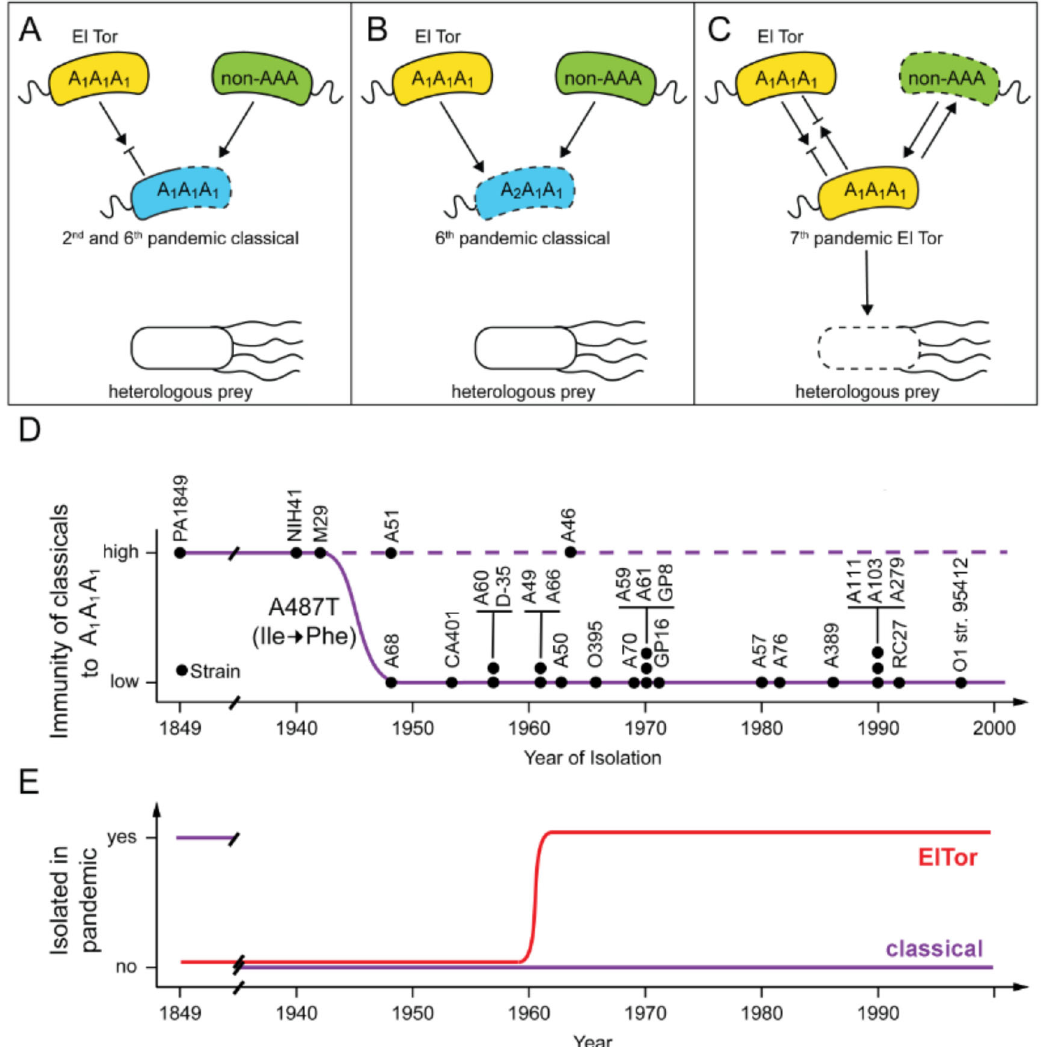
Fig. 5 Model for the competitive behaviour of non-classical and classical V. cholerae O1 serogroup strains. Panels ( A – C ) depict intraspeci fi c T6SS- mediated interactions among V. cholerae strains (yellow, azure and green bacteria) and interspeci fi c competition with heterologous pray (white bacterium) not susceptible to killing by any classical pandemic V. cholerae due to a disabled vasN Δ 293-304 allele. Classical V. cholerae are illustrated as azure bacteria, El Tor biotype are shown in yellow and non-AAA V. cholerae are fi lled in green. Dashed cell outlines represent vulnerability to attack. For clarity, interactions shown here focus exclusively on the compatibility vs vulnerability of pandemic strains (centre). A 2nd and early 6th pandemic classical V. cholerae bacteria (azure, centre) are sensitive to T6SS-mediated attack (dashed cell outline) by non-AAA V. cholerae strains (green, top right). However, compatible immunity proteins protect them against strains belonging to the same compatibility group (continuous cell outline) such as El Tors (yellow, top left). Heterologous prey bacteria are unaffected by 2nd and early 6th pandemic classical V. cholerae. B Ile163Phe conversion of TsiV1 from subfamily A 1 to A 2 leaves 6th pandemic classical V. cholerae (azure, centre) vulnerable (dashed cell outline) to T6SS-mediated attack by El Tor (yellow, top left) in addition to non-AAA V. cholerae (green, top right) while heterologous prey bacteria remain unaffected. C Classical strains are replaced worldwide by 7th pandemic El Tor strains, which are compatible with each other (yellow, top left and centre), engage their T6SS successfully against incompatible non-AAA V. cholerae (dashed green cells, top right) and are capable of killing bacterial competitors belonging to other species such as E. coli (heterologous prey) depicted below as a white cell. D Classical V. cholerae strains ( fi lled circles) listed chronologically by year of isolation ( x -axis) are plotted against immunity to T6SS- mediated attack by A 1 A 1 A 1 strains ( y -axis). The nucleotide change from adenosine to thymine at position 487 in tsiV1 that gave rise to TsiV1 163Phe is estimated to have spread among classicals in the 1940s. E The 7th cholera pandemic, starting in 1961, is caused by O1 serogroup strains of the El Tor biotype; strains of the classical biotype are only isolated sporadically and have not been involved in pandemics